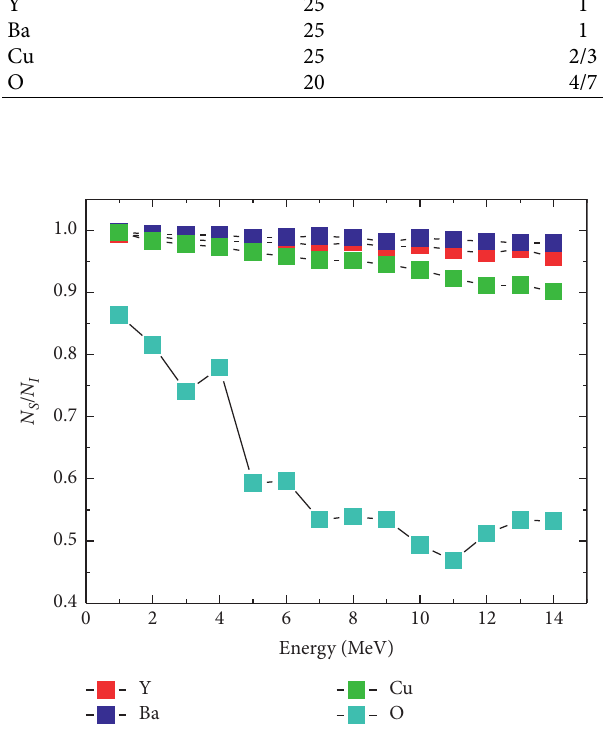
Figure 6: N s /N I caused by different PKAs for different neutron energies.